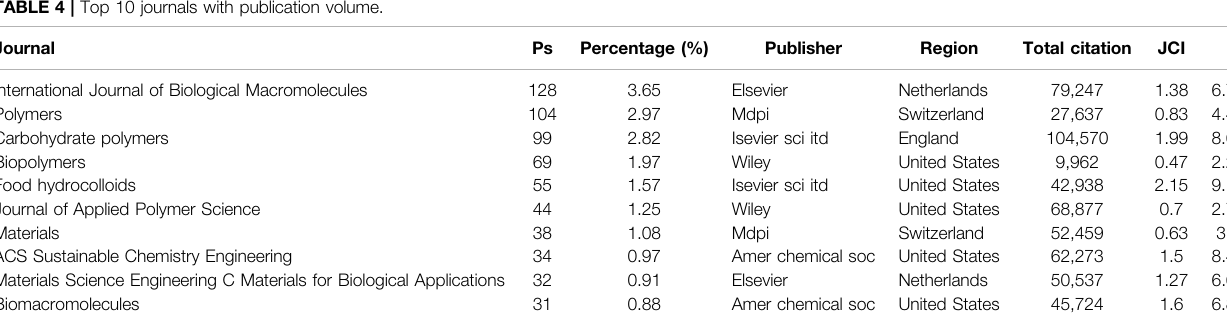
TABLE 4 | Top 10 journals with publication